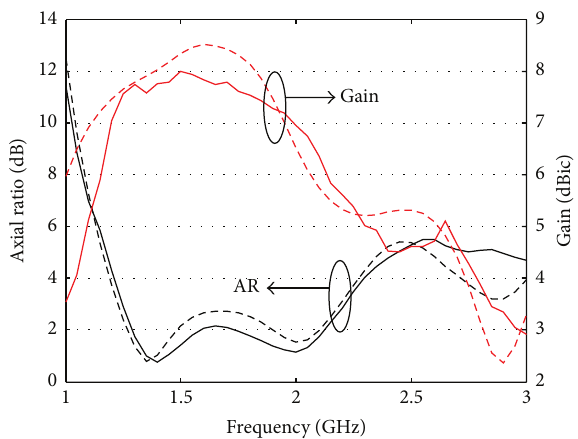
Figure 8: Axial ratio and gain against frequency of the proposed strip-helical antenna. Solid line: measured data; dashed line: simu- lated